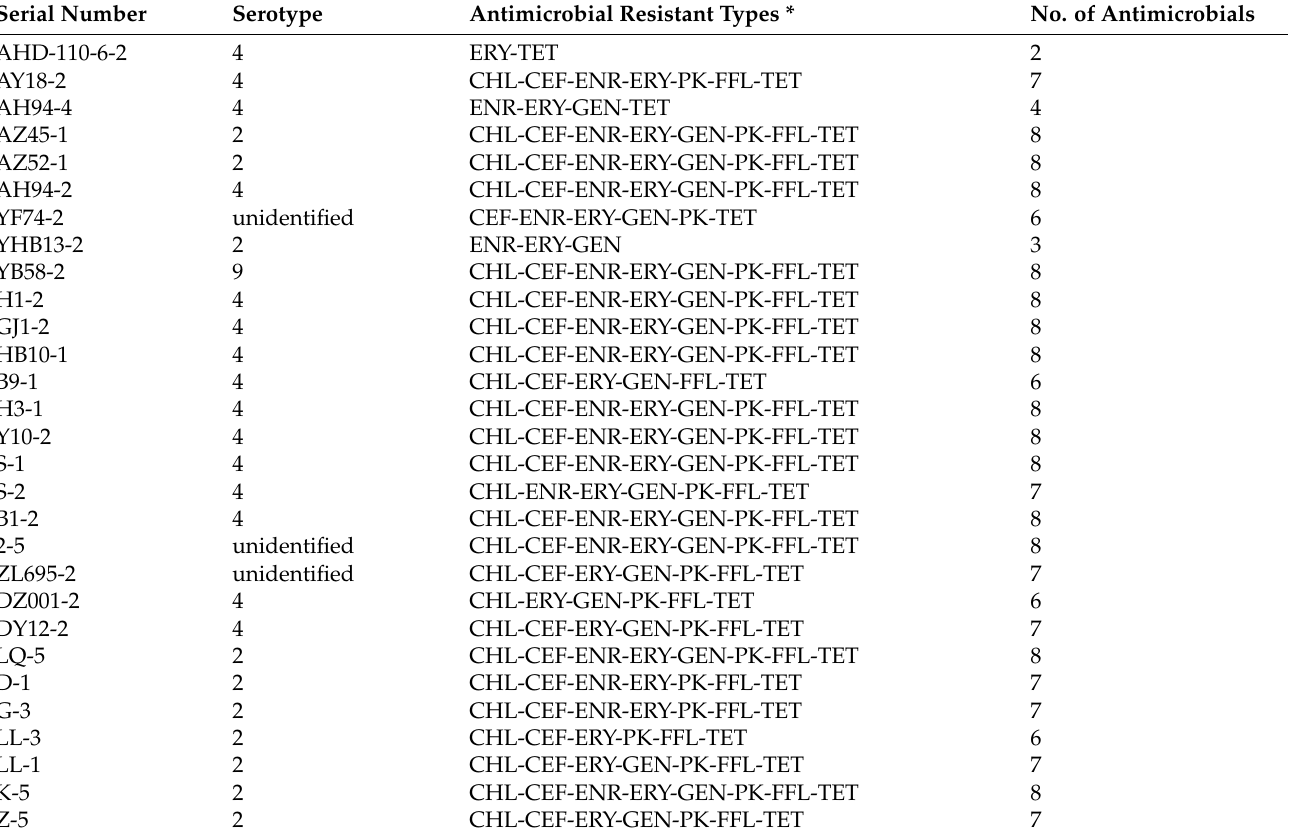
Table 1. The antimicrobial resistant types of S. suis strains isolated from pigs.